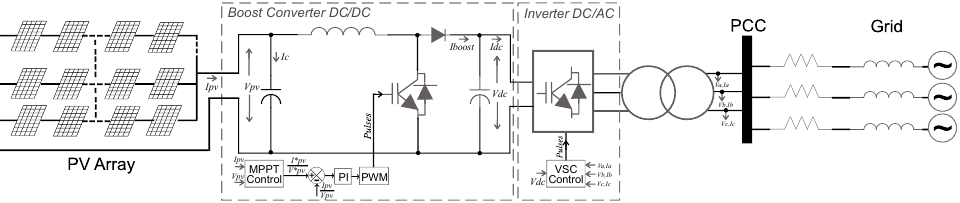
Figure 2. Simplified solar power plant diagram.